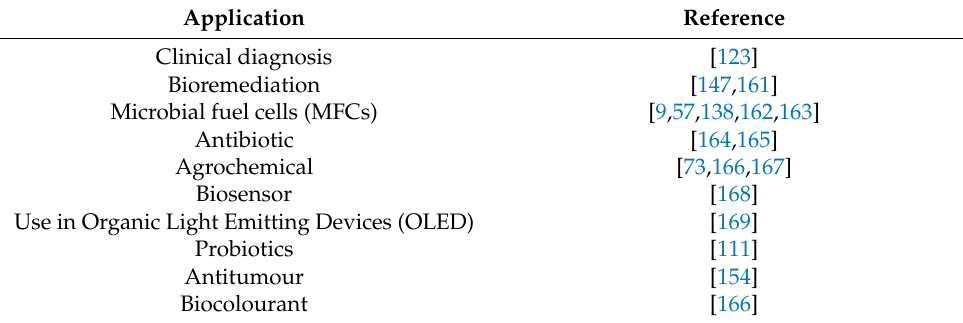
Table 2. Summary of some biotechnological application for